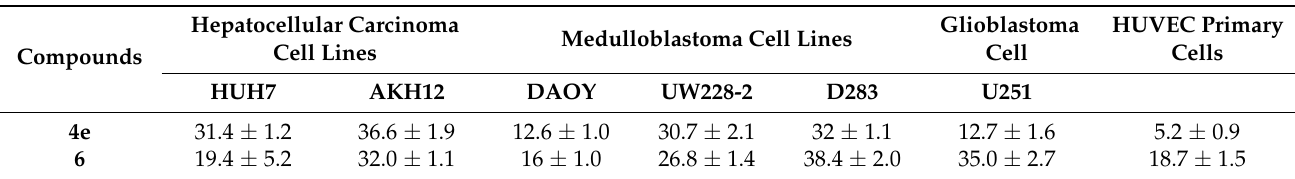
Table 2. TD 50 values (in µ M) of selected compounds tested in malignant and nonmalignant human cells by neutral red method.